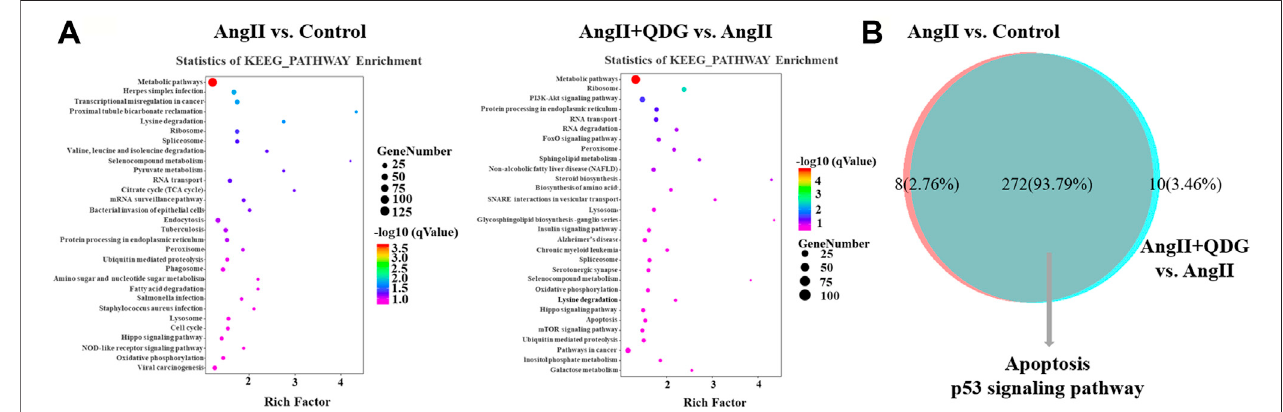
FIGURE 4 | KEGG pathway enrichment analysis. (A) KEGG enrichment analysis was performed to identify the enriched signaling pathway in both comparisons of Ang IIvs. Control(left panel) and Ang II + QDG vs. AngII(rightpanel). Thetop 30enriched signaling pathwayswerepresented. (B) Integrative analysiswasperformedto identifytheintegratedtranscriptsbetweenthetwocomparisons.TheoverlappedarearepresentsthenumberofenrichedsignalingpathwaysinbothcomparisonsofAng II vs. Control and Ang II + QDG vs. Ang II.